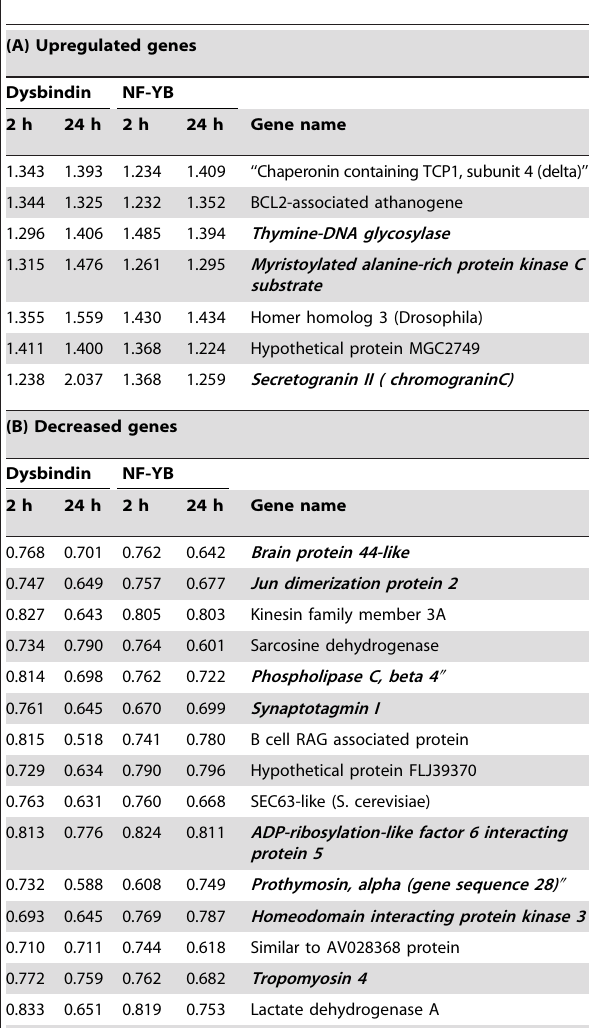
(A) The genes upregulated by the knockdown of Dysbindin that were in common with those upregulated by the knockdown of NF-YB are listed. The genes showed by bold and italic format have the CCAAT motif. (B) The genes downregulated by the knockdown of Dysbindin that were in common with those downregulated by the knockdown of NF-YB are listed. The genes showed by bold and italic format have the CCAAT